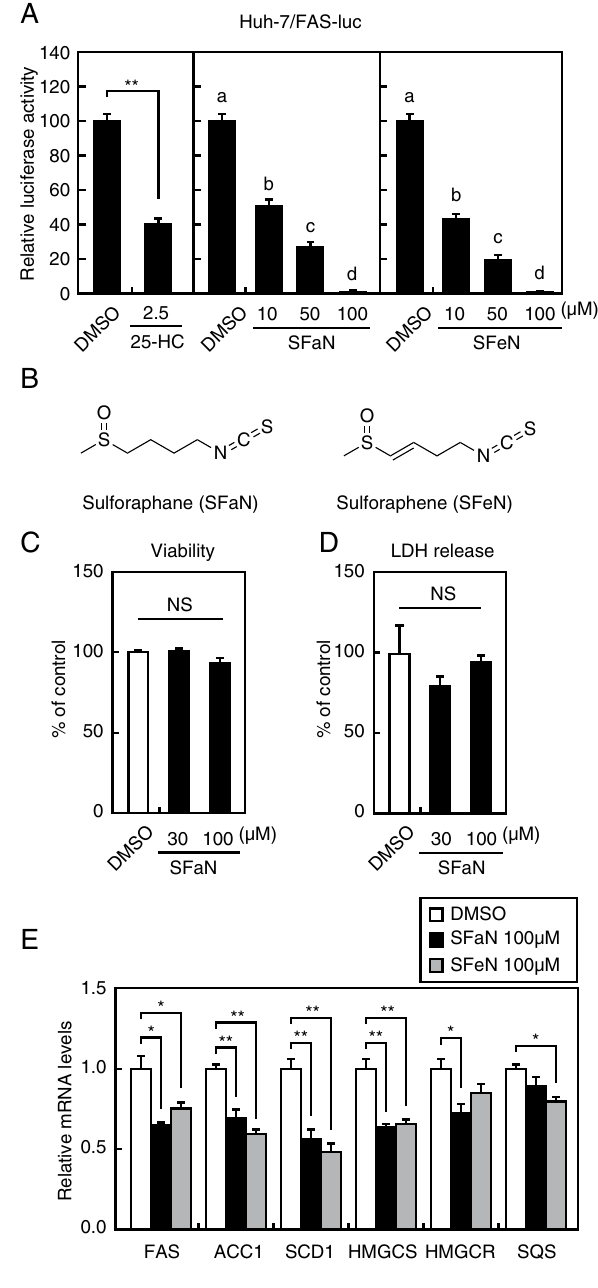
Figure 1. SFaN reduces SREBP activity. ( A ) Huh-7/FAS-luc cells were sterol-depleted by incubation in medium C for 16 h. The cells were then switched to medium C in the presence of the vehicle, 1 μg/ml 25-HC, or the indicated SFaN or SFeN concentrations. After incubation for 24 h, a luciferase assay was performed, and relative luciferase activity was obtained by activity normalization in the presence of the vehicle. All data are represented as the means Å} S.E. (n = 3). Different superscript letters denote statistical significance (p < 0.05). ( B ) SFaN and SFeN structures. ( C , D ) Huh-7 cells were treated with the indicated concentrations of SFaN for 3 h. Afterward, viability ( C ) and LDH ( D ) assays were performed. All data are represented as the means Å} S.E. (n = 3). NS = not significant. ( E ) Huh-7 cells were sterol-depleted by incubation in medium D for 16 h. The cells were then shifted into medium D in the presence of the vehicle, 100 μM SFaN, or 100 μM SFeN. After incubation for 24 h, the total RNA was isolated from the cells. Real-time quantitative PCR was performed, and relative mRNA levels were obtained by normalization to GAPDH mRNA. All data are represented as the means ± S.E. (n = 3). *, p < 0.05; **, p <